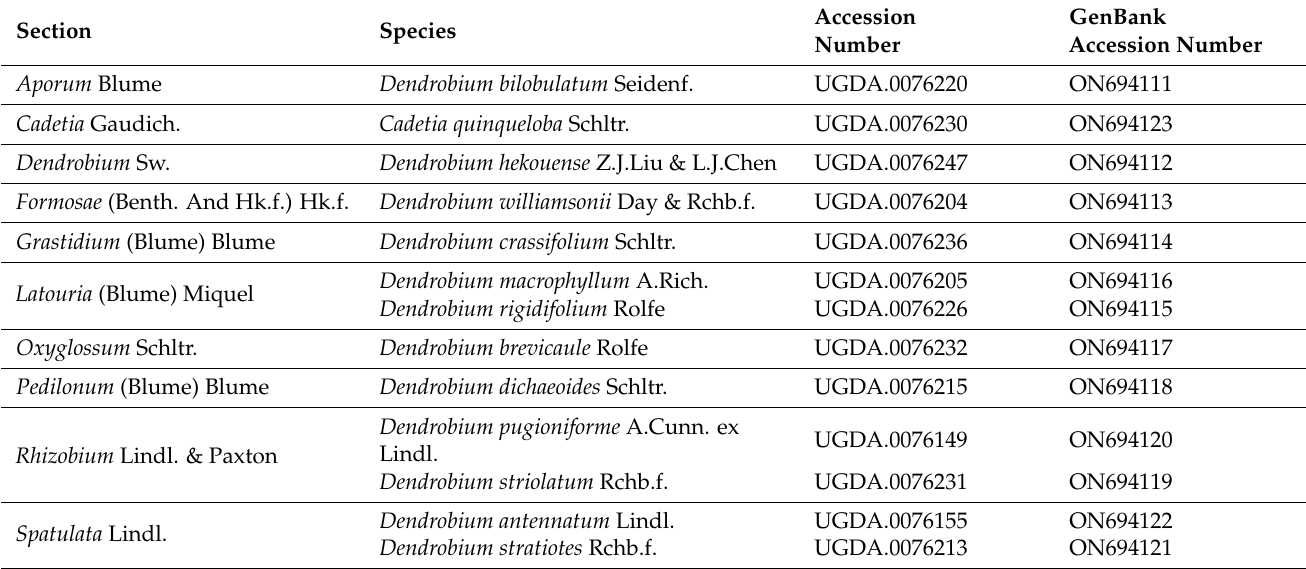
Table 4. List of species of Dendrobium used in molecular